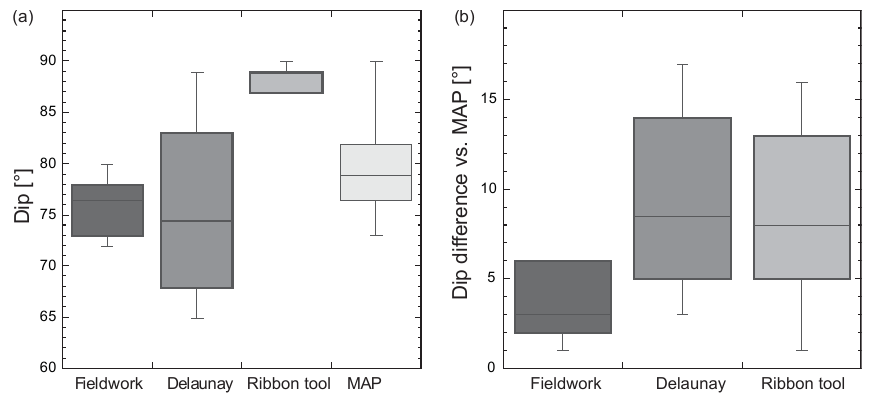
Figure 14. (a) Box plot showing dip value for different extrapolation approaches and for maximum a posteriori (MAP) interpolation. (b) Box plots for dip comparison between different extrapolation approaches and the maximum a posteriori (MAP) interpolation.